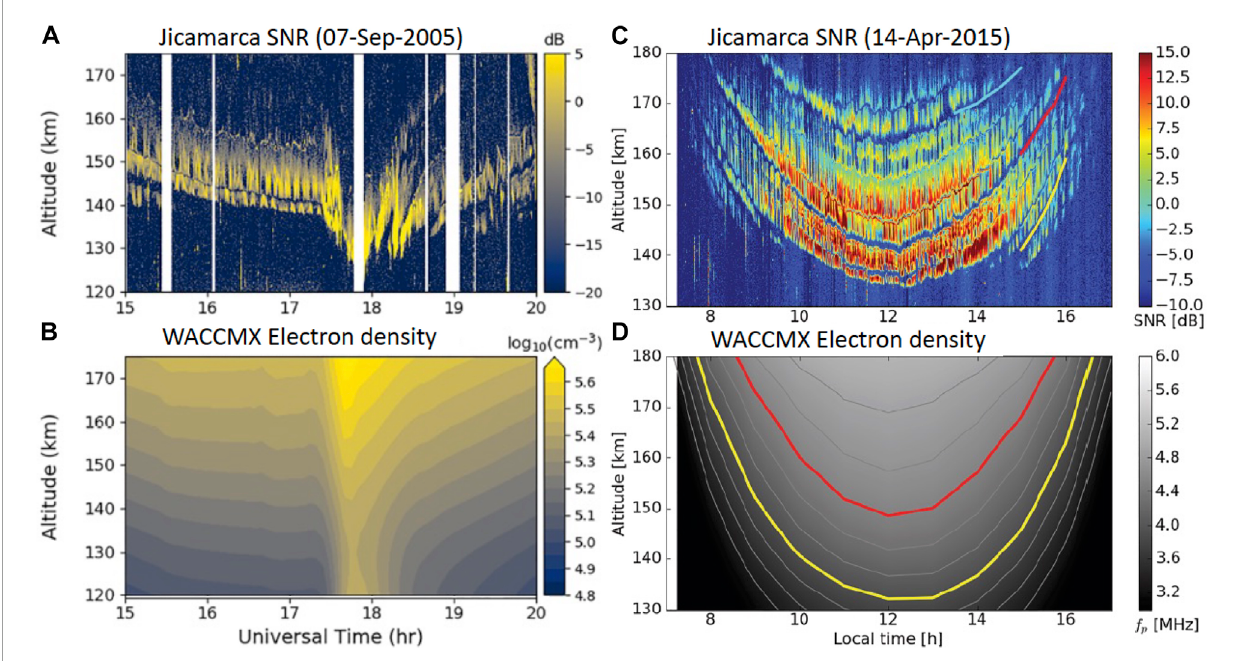
FIGURE 11 SNR observations of 150-km echoes over Jicamarca on (A) 07-September-2005 and (C) 14-April-2015 and their corresponding simulated electron densities by the Whole Atmosphere Community Climate Model with thermosphere-ionosphere eXtension (WACCM-X) shown in (B, D) , respectively. White areas in (A) indicate time periods without observations. The 07-Sep-2005 observations corresponds to a solar flare event. Yellow and red lines in (D) corresponds to 3.9- and 4.5-MHz contours, they in turn appear to corresponds to the wide gaps in (C) (adapted from Pedatella et al., 2019; Lehmacher et al., 2020, Figures 1, 4,